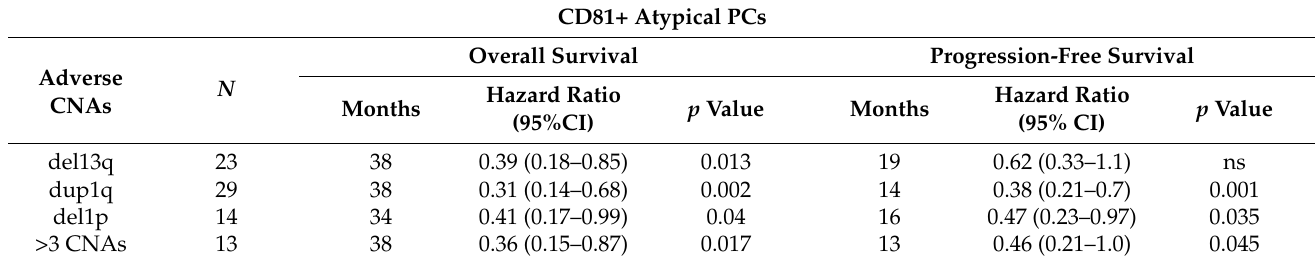
Table 3. Correlation of CD81 expression with adverse CNAs and clinical prognosis of MM patients estimated by Kaplan–Meier and COX regression analysis.